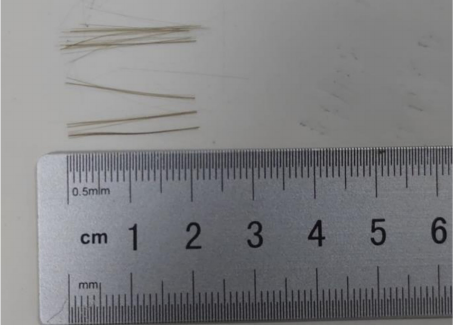
Figure 4. Basalt fiber